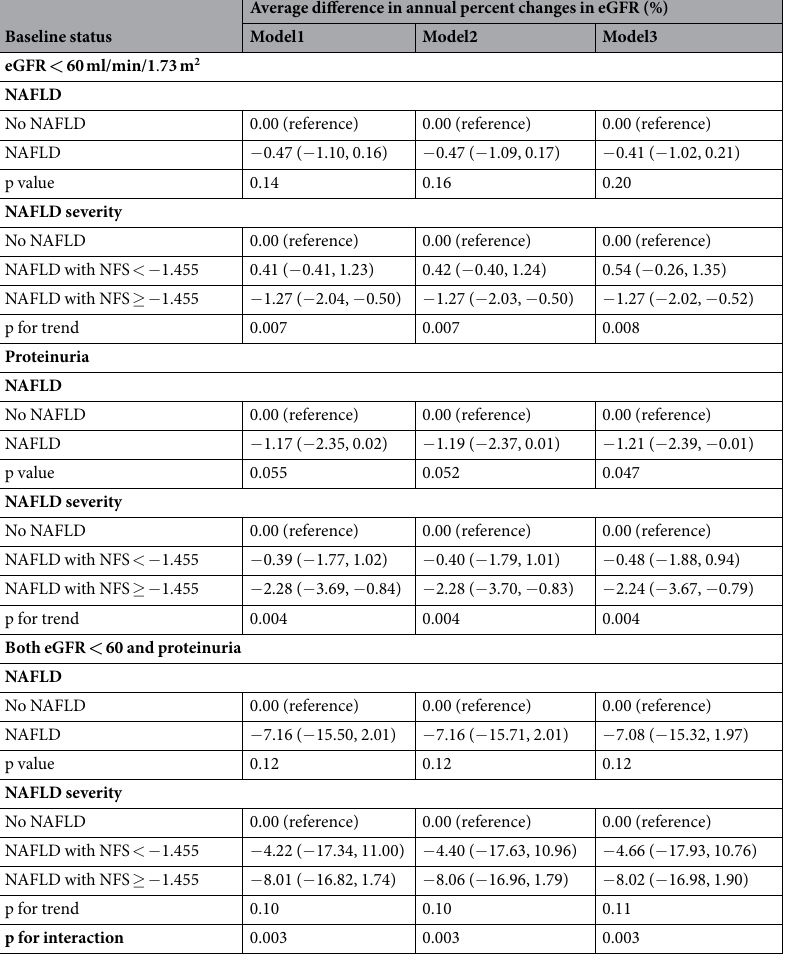
progression and may help identify patients with a higher risk of rapid progression. CKD patients may benefit from screening and management of NAFLD, which warrants prospective validation.